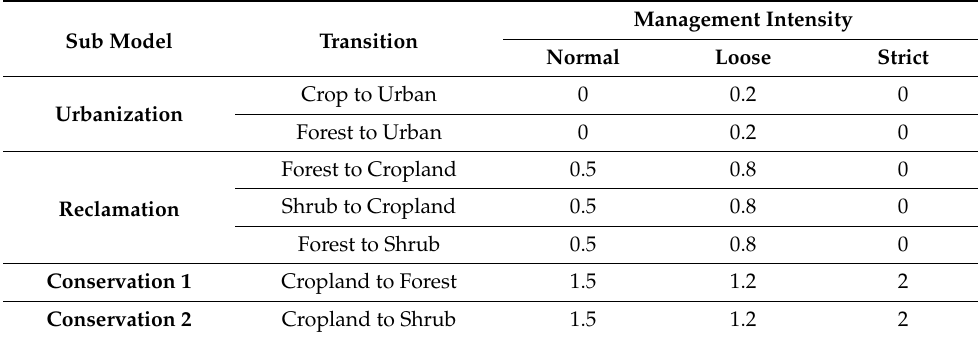
Table 9. Constraint coefficients under different management